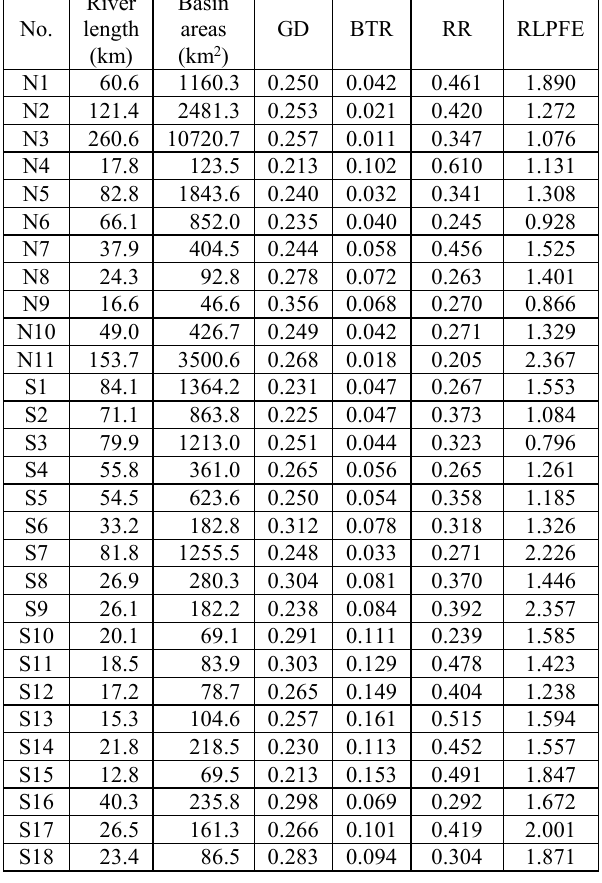
Table 1. The main results in the study